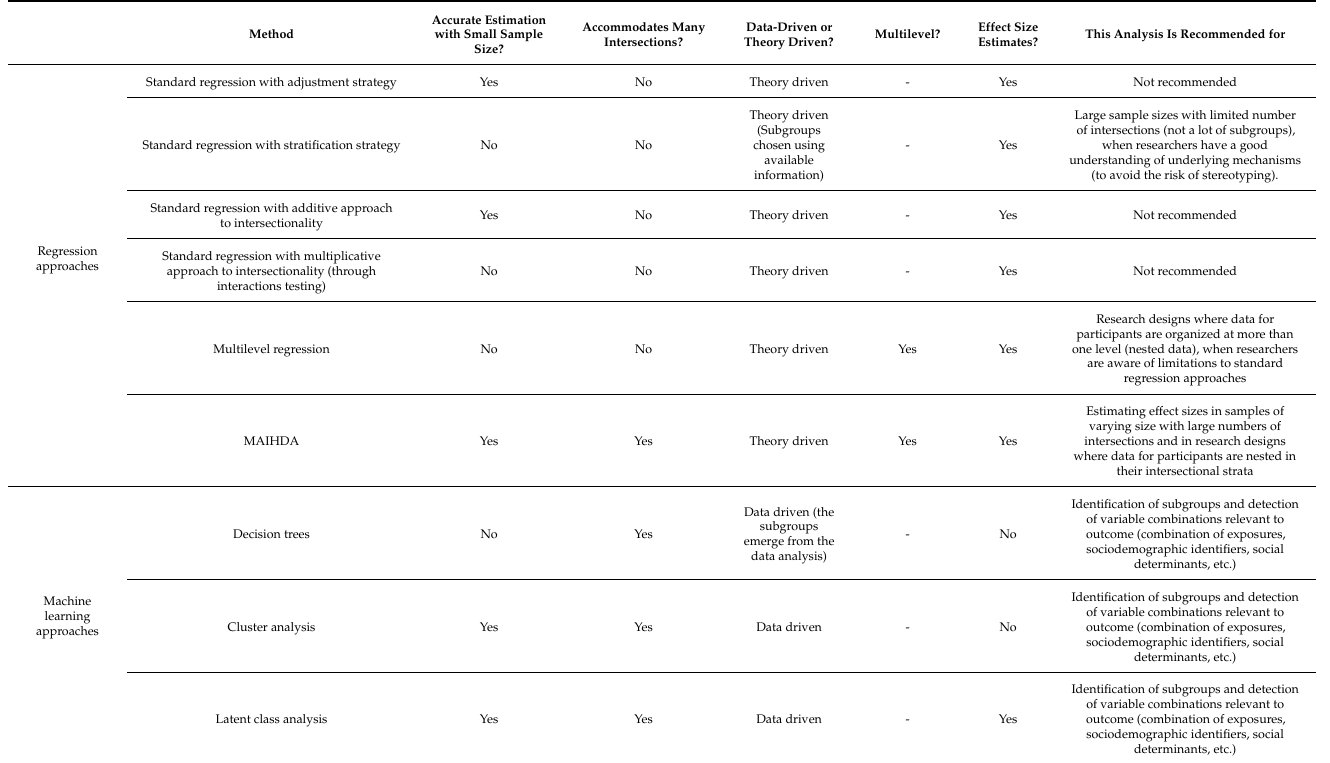
Table 1. Characteristics of included statistical tools for identifying exposure-effect relations with an intersectional